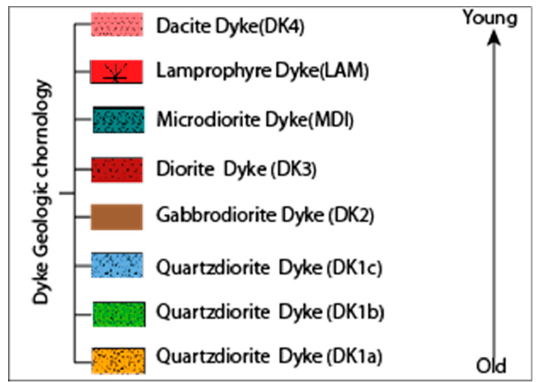
Figure 3. Classification of post-mineralization dykes is based on relative intrusive age.